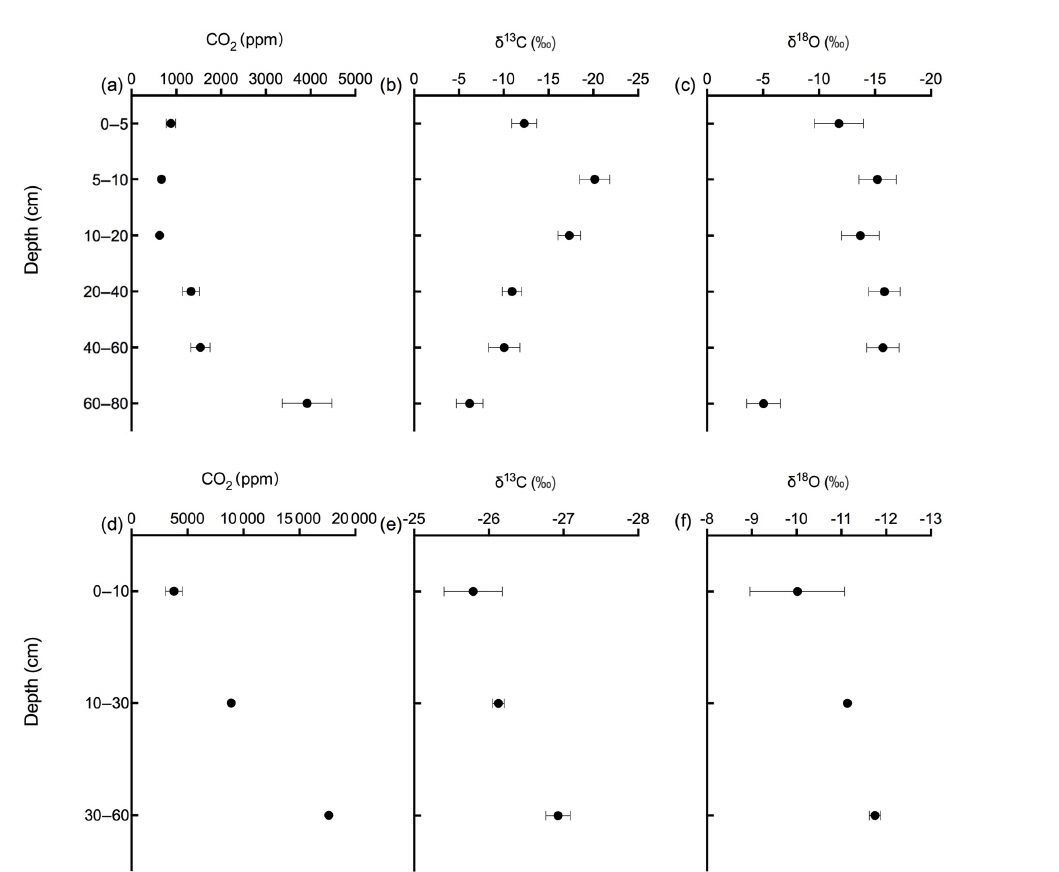
Figure 10. Daily average data of soil CO 2 (ppm), δ 13 C, and δ 18 O in calcareous (a, b, c) and acidic (d, e, f) soils across soil depth profiles.